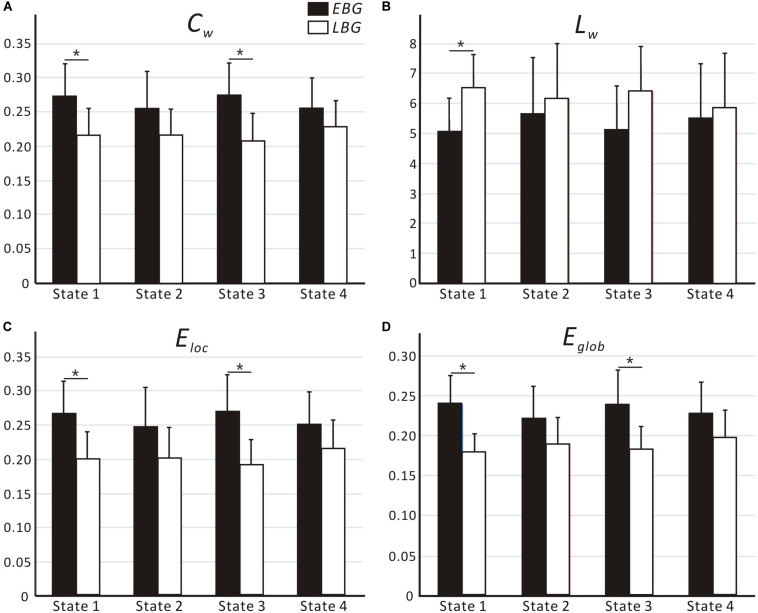
Dynamic topological properties of the language network, including (A)
Cw, (B)
Lw, (C)
Eloc and (D)
Eglob, for both the early bilingual group (EBG) and late bilingual group (LBG) in each dFC state. For a given parameter, the bar corresponds to the mean value and the error bar to the standard deviation of a group (black: EBG, white: LBG). Abbreviations: Cw, clustering coefficient; Lw, characteristic path length; Eloc, local efficiency; Eglob, global efficiency; *p < 0.05, FWE-corrected.